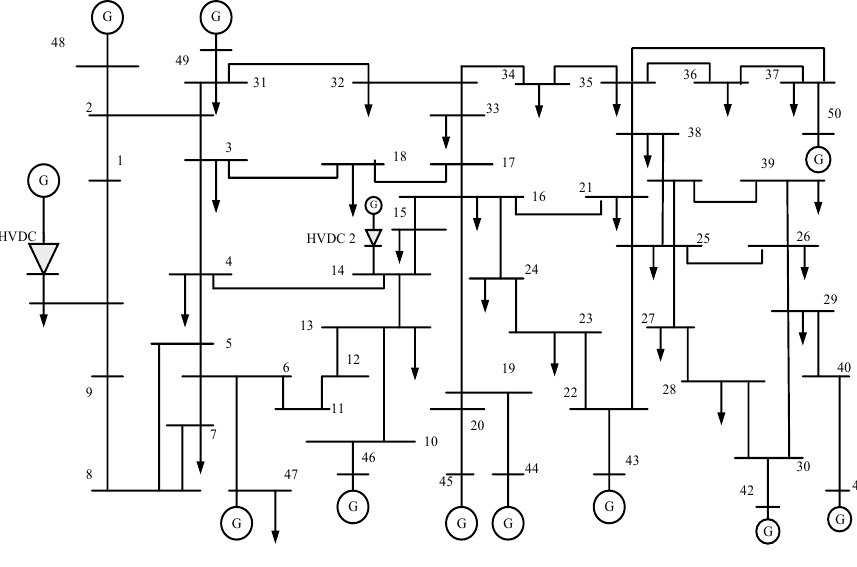
Figure 5. IEEE 50-bus system.